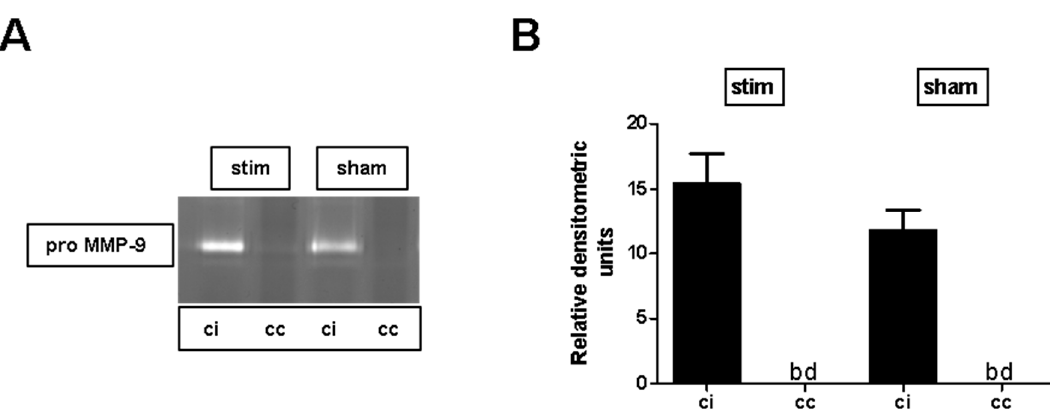
Figure4. Stimulationofthemesencephaliclocomotorregiondoesnotmodulatephotothrombosis-driven Figure 4. Stimulation of the mesencephalic locomotor region does not modulate pro-matrix metalloproteinase (MMP)-9 expression. ( A , B ) Representative experiment of zymography photothrombosis-driven pro-matrix metalloproteinase (MMP)-9 expression. ( A , B ) Representative bands (cc, cortex contralesional; ci, cortex ipsilesiona; bd, beyond detection limit) and densitometric experiment of zymography bands (cc, cortex contralesional; ci, cortex ipsilesiona; bd, beyond quantification of pro-MMP-9 expression in the cortical regions 27 h after photothrombosis of detection limit) and densitometric quantification of pro-MMP-9 expression in the cortical regions 27 unstimulated (sham) and high-frequency stimulated (stim) rats ( n = 5–7 / group). One-way h after photothrombosis of unstimulated (sham) and high-frequency stimulated (stim) rats ( n = 5 – 7/group). One-way ANOVA.